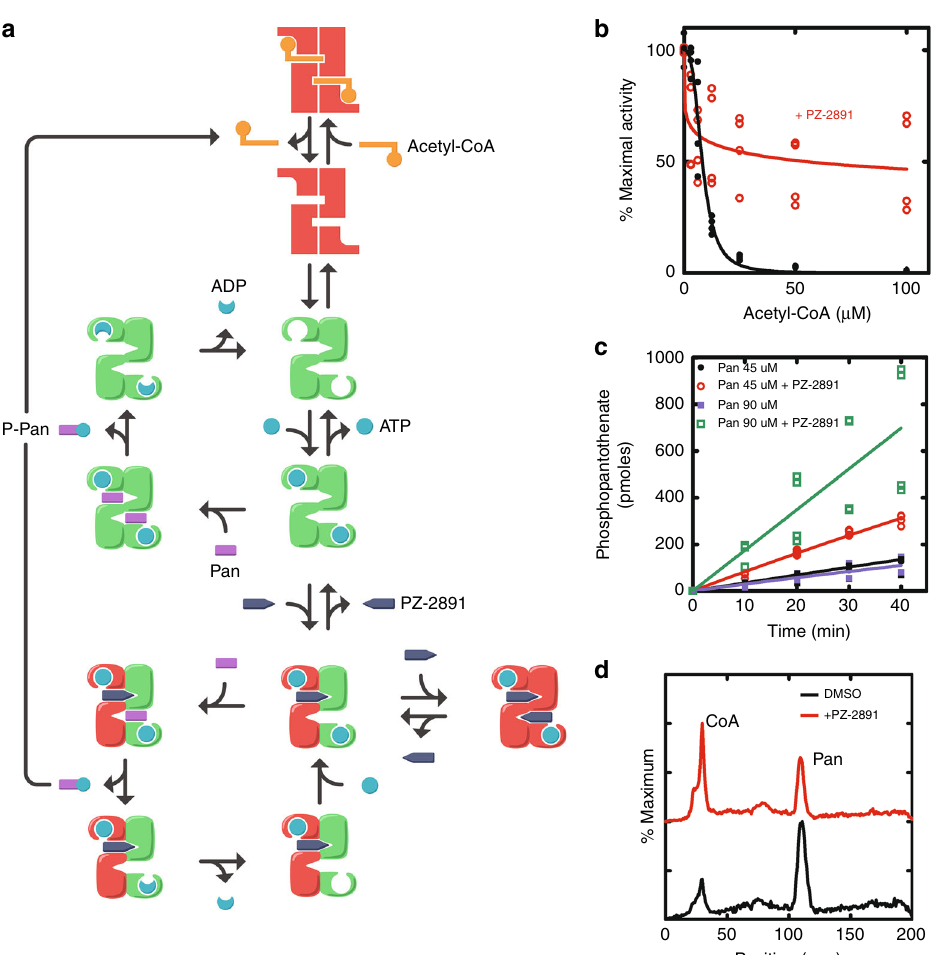
Fig. 3 Activation of PanK by PZ-2891. a Kinetic model illustrating how PZ-2891 binding activates PANK3. PANK3 is a highly-cooperative enzyme where both active sites exist in either the active or inactive conformation. The inactive ‘ open ’ conformation (red rectangles) is stabilized by the binding of acetyl- CoA, and the active ‘ closed ’ conformation (green or curved shape) is stabilized by ATP binding. In the normal catalytic cycle, PANK3 returns to a ligand- free state that allows it to bind acetyl-CoA and switch to the inactive conformation. PZ-2891 binds tightly to the active, ATP-bound PANK3 conformation. When a fraction of PANK3 is occupied by PZ-2891, the catalytic cycle is operating on only one protomer of the dimer. In this catalytic cycle, the active monomer of PANK3 empties, but remains locked in the active conformation by ATP (cid:129) Mg 2 + (cid:129) PZ-2891 binding to the other protomer. The drug-induced catalytic cycle prevents PANK3 from adopting the open, inactive conformation making PANK3 refractory to feedback regulation by acetyl-CoA. Pan pantothenate, P-Pan phosphopantothenate. b PZ-2891 renders PANK3 refractory to acetyl-CoA inhibition. PANK3 (1 μ g/assay) activity at different concentrations of acetyl-CoA was determined with ATP (1 mM) in the presence (open red circles) and absence ( fi lled circles) of 2.5 μ M PZ-2891. c The time course assays contained PANK3 (1 μ g/assay), ATP (1 mM) and acetyl-CoA (100 μ M) such that PANK3 was inhibited about 95% by acetyl-CoA in the absence of pantazine. The addition of 2.5 μ M PZ-2891 to the assay increased the PANK3 rate in a pantothenate-dependent manner. Filled black circles are 45 μ M pantothenate, fi lled blue squares are 90 μ M pantothenate, red open circles are 45 μ M pantothenate plus 2.5 μ M PZ-2891, and green open squares are 90 μ M pantothenate plus 2.5 μ M PZ-2891. Data in b and c are from two independent experiments that were performed in duplicate. d C3A cells were radiolabeled with [ 3 H]pantothenate in the presence (red trace) or absence (black trace) of 10 μ M PZ-2891 for 24 h. The cells were extracted, and the labeled metabolites were analyzed by thin-layer chromatography and imaged with a Bioscan detector. Representative chromatograms from two independent experiments in duplicate are